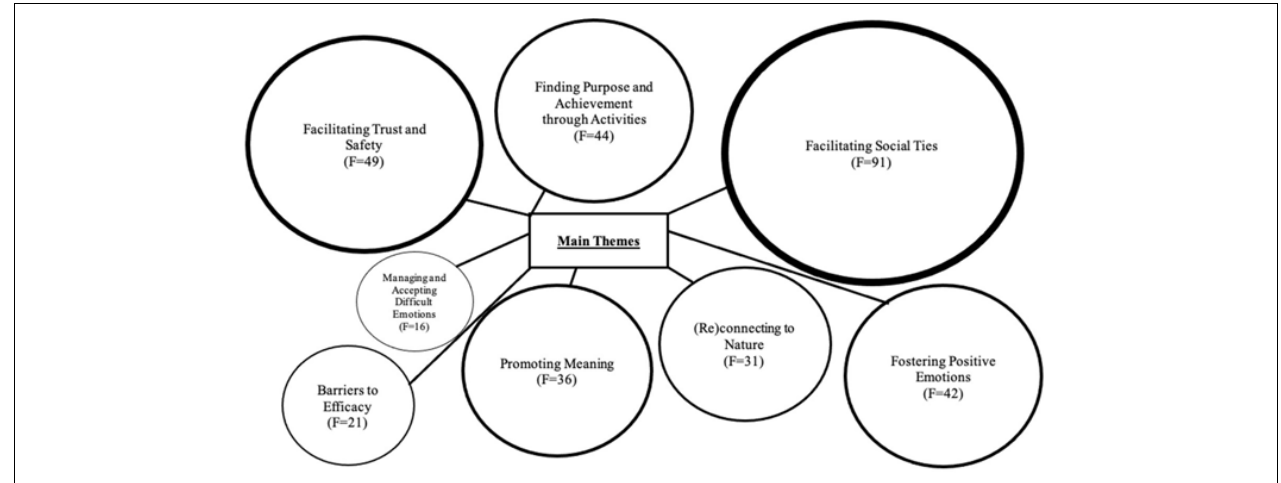
FIGURE 2 | Figure representing the main themes from the results, whereby F , Frequency of times theme is mentioned within the transcripts. Size of theme represents frequency mentioned.